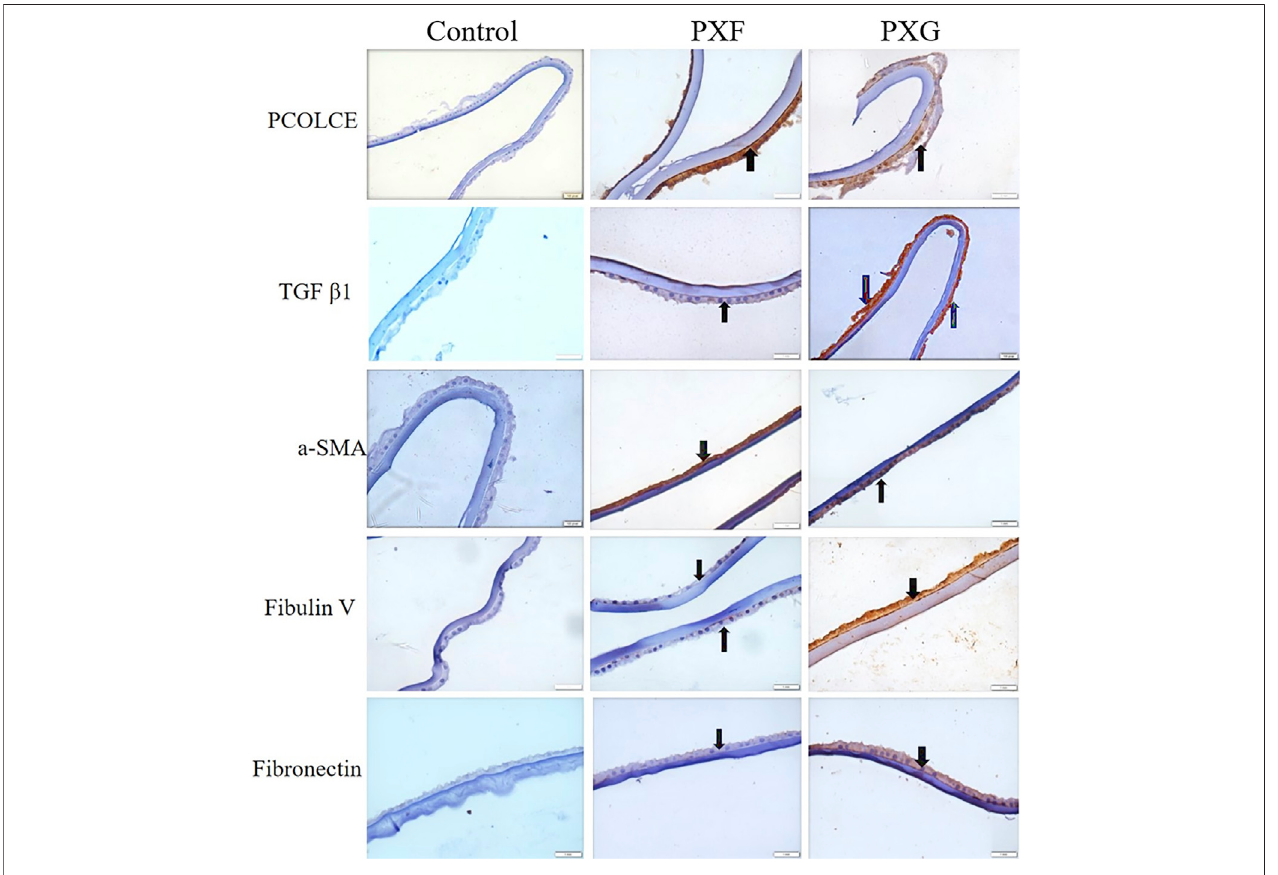
FIGURE 3 | Evaluation of the protein of interest involved in ECM aggregation in LCs by immunohistochemistry. Bright- fi eld microscopic images at ×40 magni fi cations of PCOLCE, TGF β 1, a-SMA, fi bulin V, and fi bronectin in the LC. Black arrows indicate immunopositivity of the highlighted/target proteins in the LC. TGF β 1, a-SMA, fi bulin V, and fi bronectin were highly expressed in PXG compared to PXF/control. Scale bar-10 um, PXF-pseudoexfoliation, PXG-pseudoexfoliation glaucoma, PCOLCE-procollagen C-endopeptidase enhancer 1, TGF β 1-transforming growth factor, a-SMA (anti-alpha smooth muscle actin).